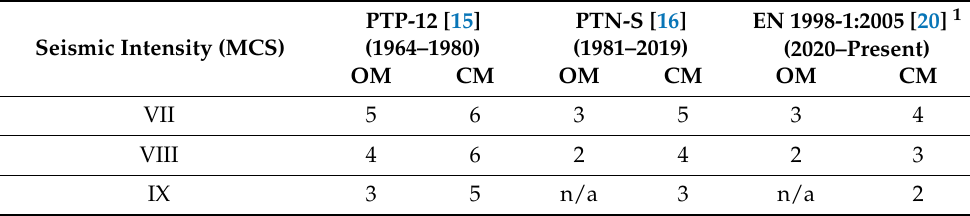
Table 2. Code-prescribed height limits (maximum number of storeys) for URM (OM) and confined masonry (CM) buildings